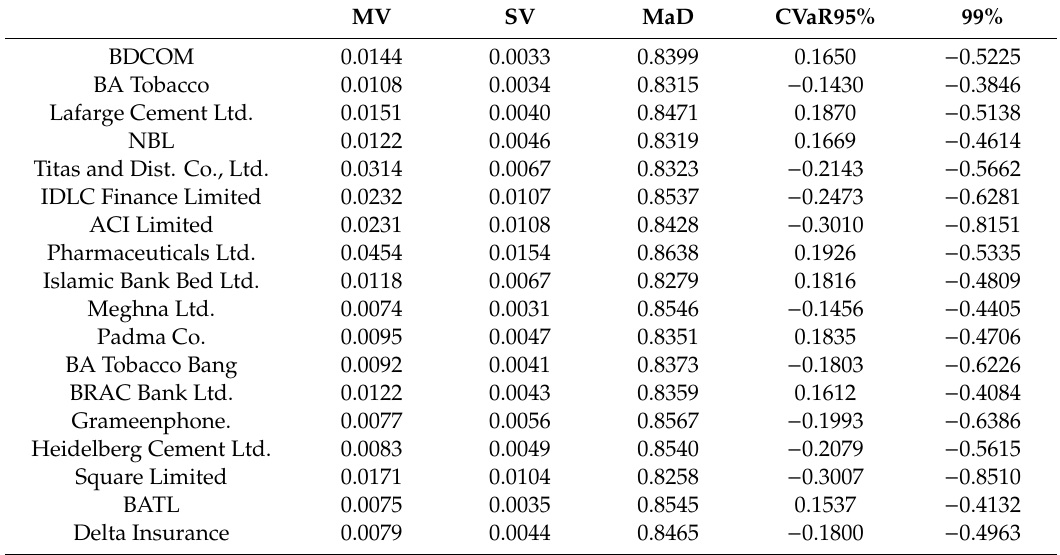
Table 5. Optimal portfolio compositions for economic recovery period (2010–2013).